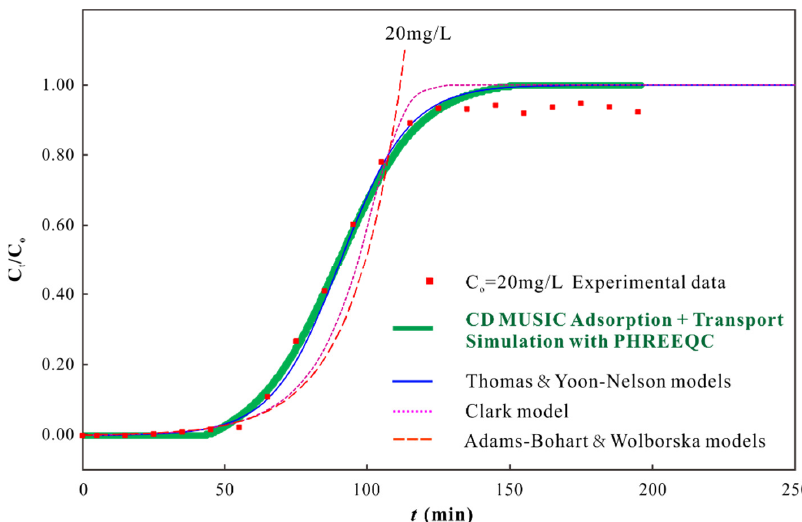
Figure 14. Experimental data and coupled CD ‐ MUSIC–transport simulation, using PHREEQC, for PC ‐ Fe/C ‐ B adsorption As(V) (initial concentration of As(V) = 20 mg/L, pH = 3, Q = 5.136 mL/min, dose m = 0.5 g, particle size < 0.149 mm, T = 35 °C).